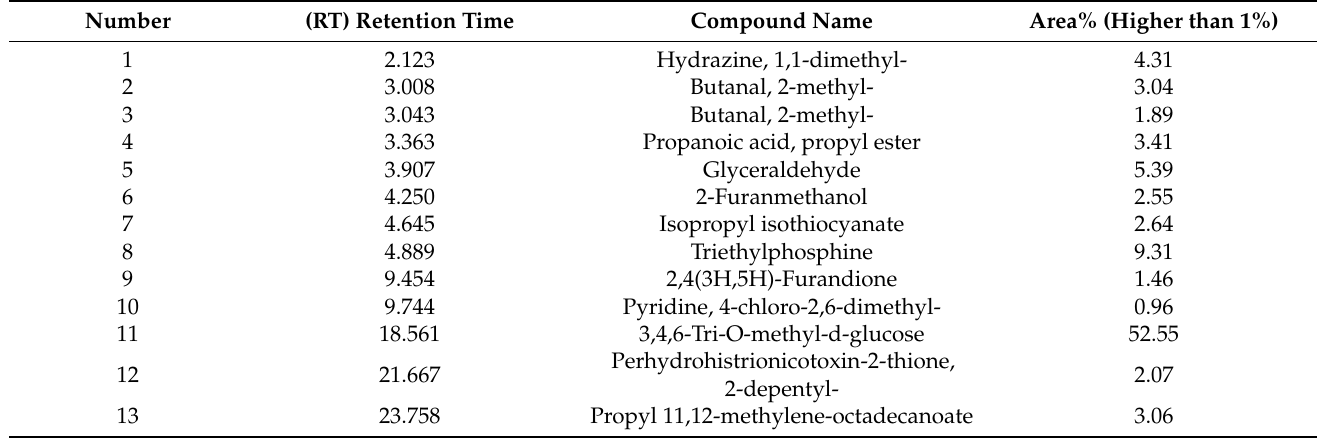
Table 1. Chemical groups and compounds present in the B . aegyptiaca fruit aqueous